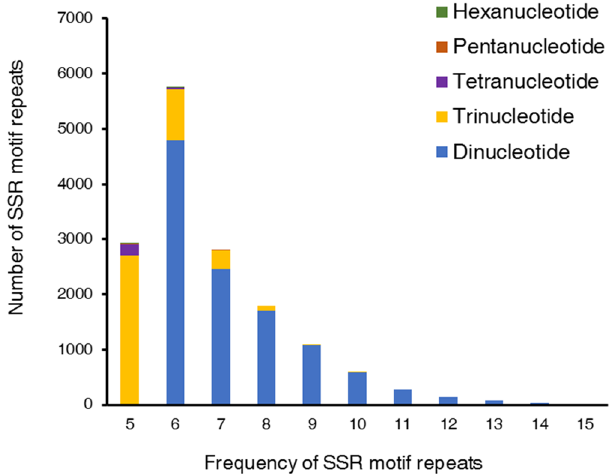
Figure 3. Distribution and frequency of SSR motif repeat numbers. The X-axis shows the frequencies of SSR types, while the Y-axis shows SSR repeat